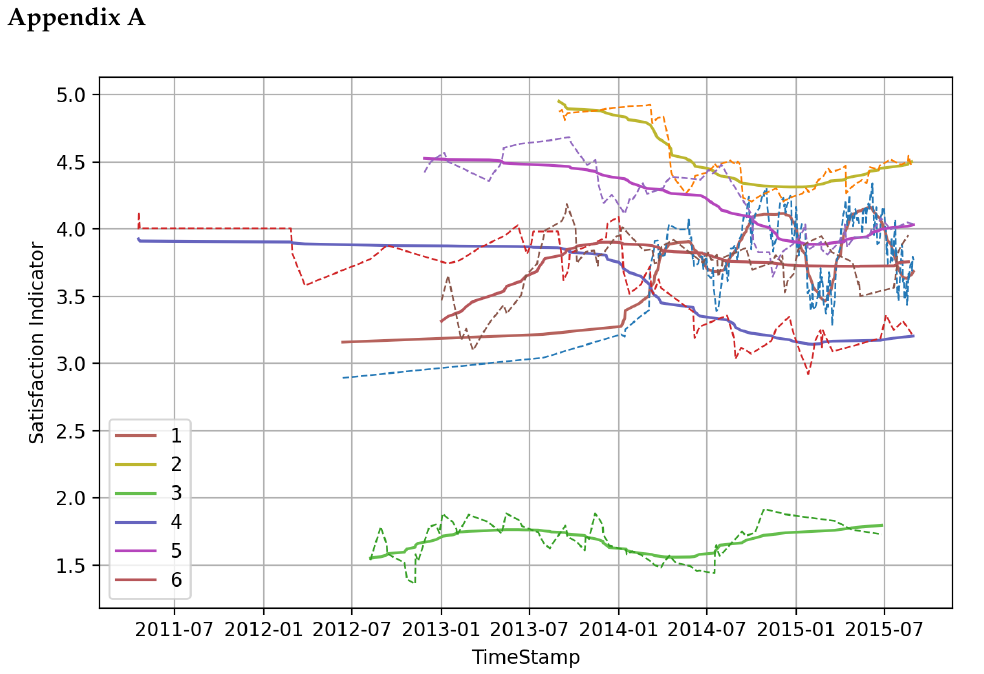
Figure A1. Satisfaction curve of different brands of microwave oven. The six lines in the picture represent these commodities: 1 refers to the Danby 0.7 cu.ft. countertop microwave; 2 refers to the microwave cavity paint 98Qbp0302; 3 refers to the Samsung SMH1816S 1.8 cu. ft. stainless steel over- the-range microwave; 4 refers to the Sharp microwave drawer oven; 5 refers to the Whirlpool stainless look countertop microwave, 0.5 cu. feet, WMC20005YD; 6 refers to the Whirlpool WMC20005YB 0.5 cu. ft. black countertop microwave.